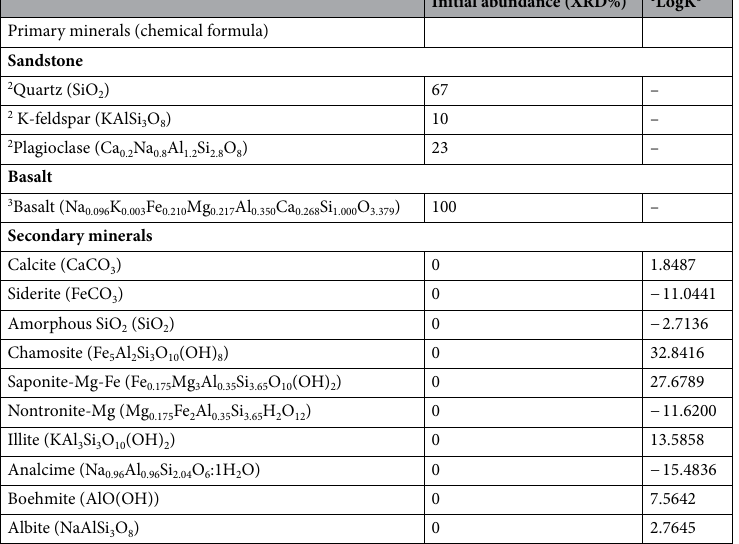
phases used in the model were based on petrographic studies of the Rosebank core samples 16 . Basalt chemis- try was adopted from 16 (Table 1). Minerals assumed to form by basalt-water reactions but auto-formed in the sandstone were suppressed by forcing oversaturation by fixing a SI of 3 for saponite-Mg–Fe (Table 1) for pre- cipitation. Quartz and feldspar amounts were averaged for core 213/27-2 in the depth range between 2932.32 to 2953.38 mRKB 16 . Some modifications of secondary phases were necessary, as thermodynamic data for inter- mixed smectite/chlorites phases were not available. To accommodate this, several different smectite and chlorite compositions were used (Table 1). Boehmite (AlO(OH)) and illite were incorporated as secondary phases to avoid build-up of Al concentrations to unreasonable levels. Primary siliciclastic minerals and basalt reacted according to kinetic rate equations as stated below, while sec- ondary phases precipitated and dissolved based on the principle of local thermodynamic equilibria 52 . The choice of using a local thermodynamic equilibrium for the secondary phases is to reduce the complexity of the model and reduce computation time. Additionally, this is a common assumption due to the low solubility of aqueous aluminium and the aluminosilicates 41 . Mineral abundances and kinetic parameters used are displayed in Tables 1 and 2, respectively. Incorporated minerals were available through the carbfix.dat thermodynamic database 37 . Solutes from a seawater standard was used 53 to simulate mineral interaction and diffusion. The initial com- position was modified by equilibrating the solution at reservoir temperature with quartz, K-feldspar and cal- cite. The carbon content was calculated reflecting calcite equilibrium and CO 2 fugacity reported for North Sea hydrocarbon reservoirs at 80 °C which equals log pCO 2 of 0.07 35 . Finally, redox potential was calculated based on hematite-magnetite equilibrium at reservoir temperature 54 giving a pE of − 4.261 (Table 3). This was done as the formation water composition at Rosebank is unknown. The resulting fluid composition is displayed in Table 3. PHREEQC use an extended Debye-Hückel (Truesdell-Jones) model to simulate the ion activity 17 . Diffusion. Diffusion was modelled using an effective diffusion coefficient D eff calculated from: